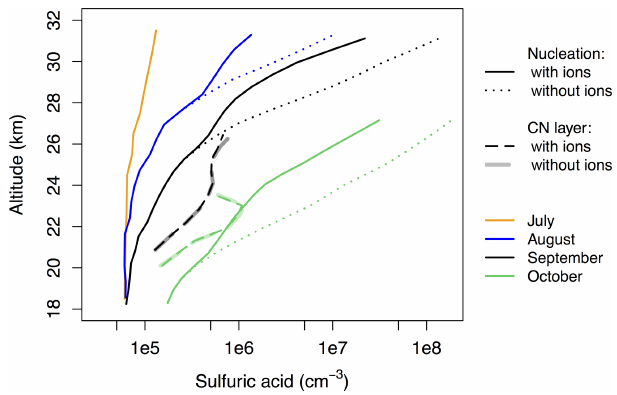
Figure 5. Comparison of the nucleation threshold sulfuric acid profiles derived including ion-induced nucleation (solid lines) and without simulating ions (dotted lines). At low sulfuric acid concen- trations the derived profiles do not change. The CN layer profiles also hardly change (thick dashed lines; grey and light green are without ions and black and green are with ions, but they are almost